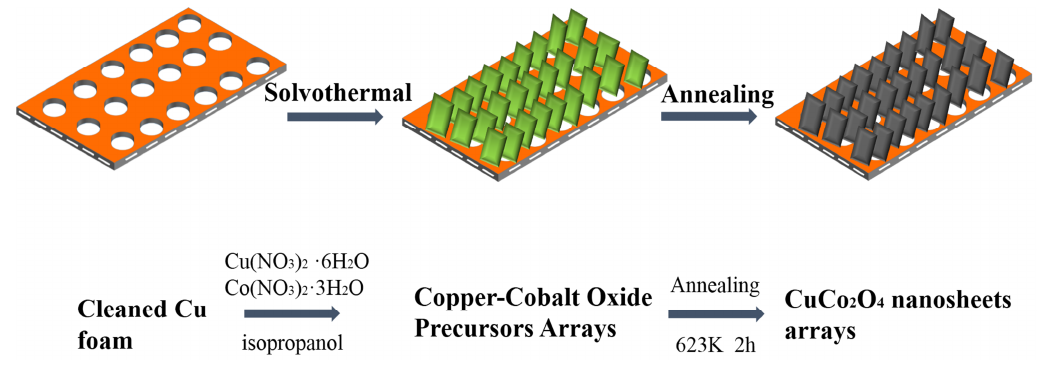
Figure 1. Illustration fabrication route of CuCo 2 O 4 nanosheets on Cu foam.